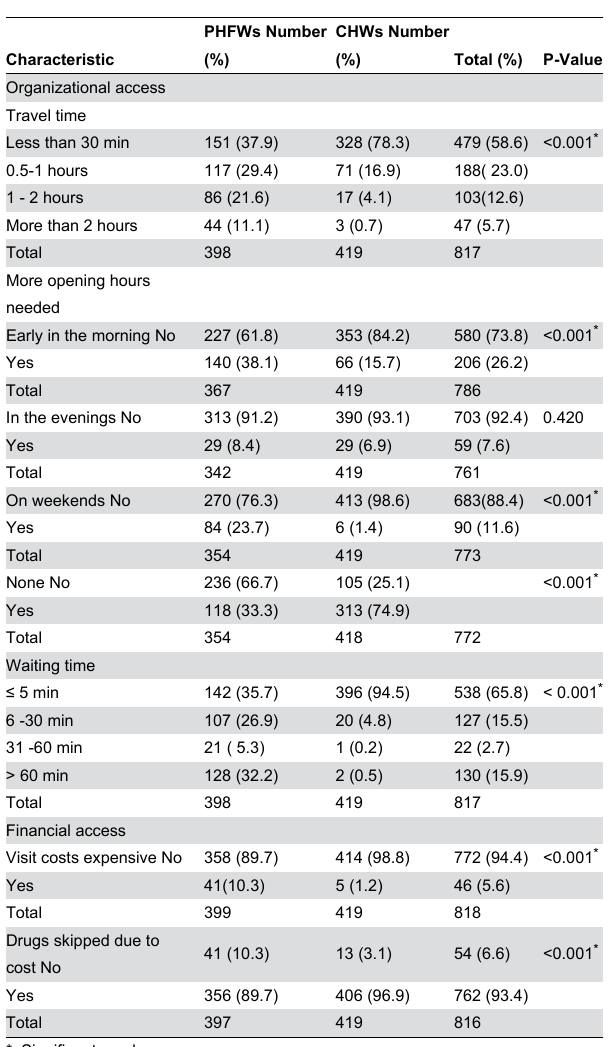
Table 4. Difference in perceived quality of care between caretakers of children visiting community health workers and primary health